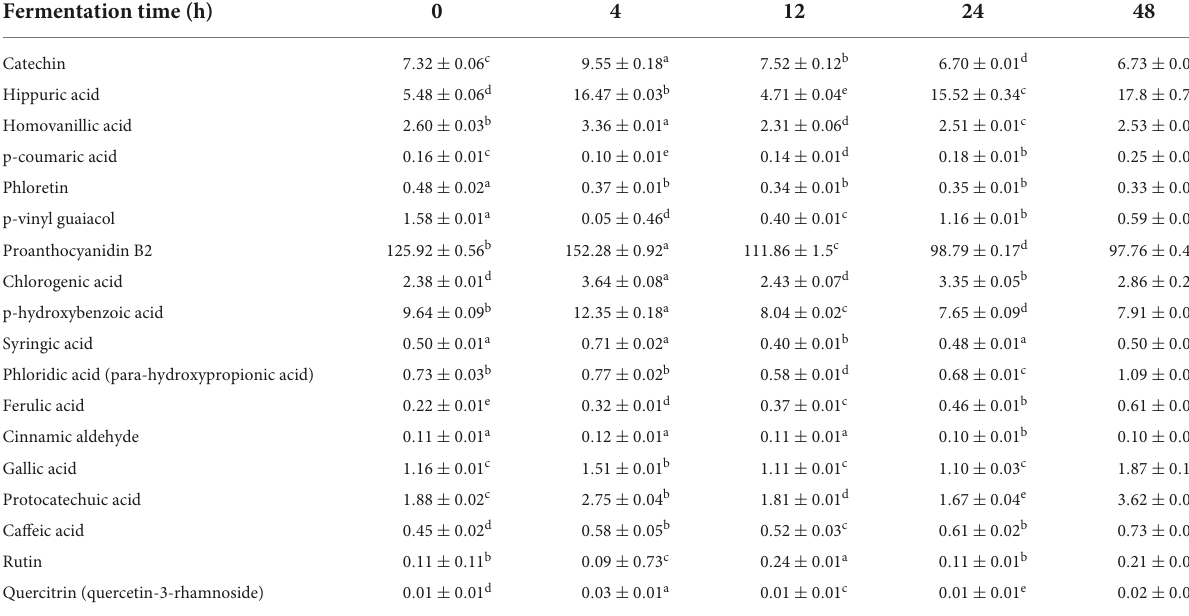
TABLE 5 Changes in the content of different phenolic acids during fermentation ( µ g/mL). Fermentation time (h)